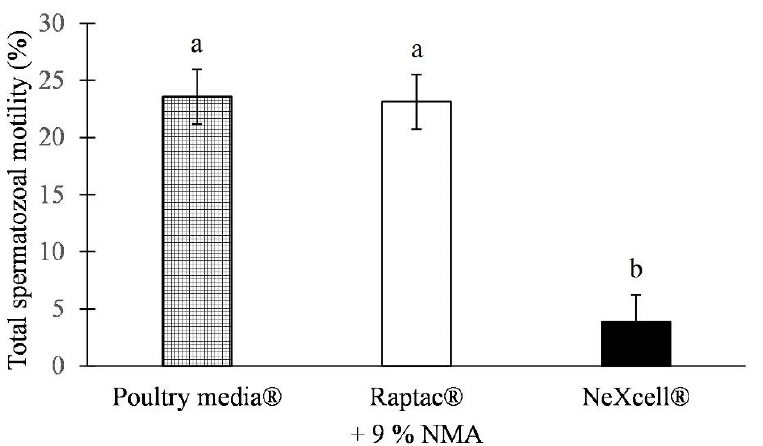
Figure 2. The percentage of the motile post-thaw spermatozoa (MOT) cryopreserved in different commercial extenders supplemented with 9% N-methylacetamide (least square means ± standard error). a,b Different letters indicate differences between groups within a column ( p < 0.05). Table 3. Impact of semen extender supplemented with defined cryoprotective agent on the plasma membrane and acrosome intactness (PAI), plasma membrane damage (PMD) and acrosome damage (ACRD) of thawed rooster sperm (least square means ± standard